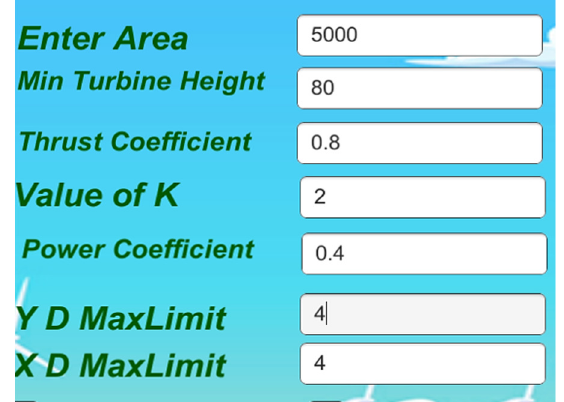
Fig. 3: Wind farm